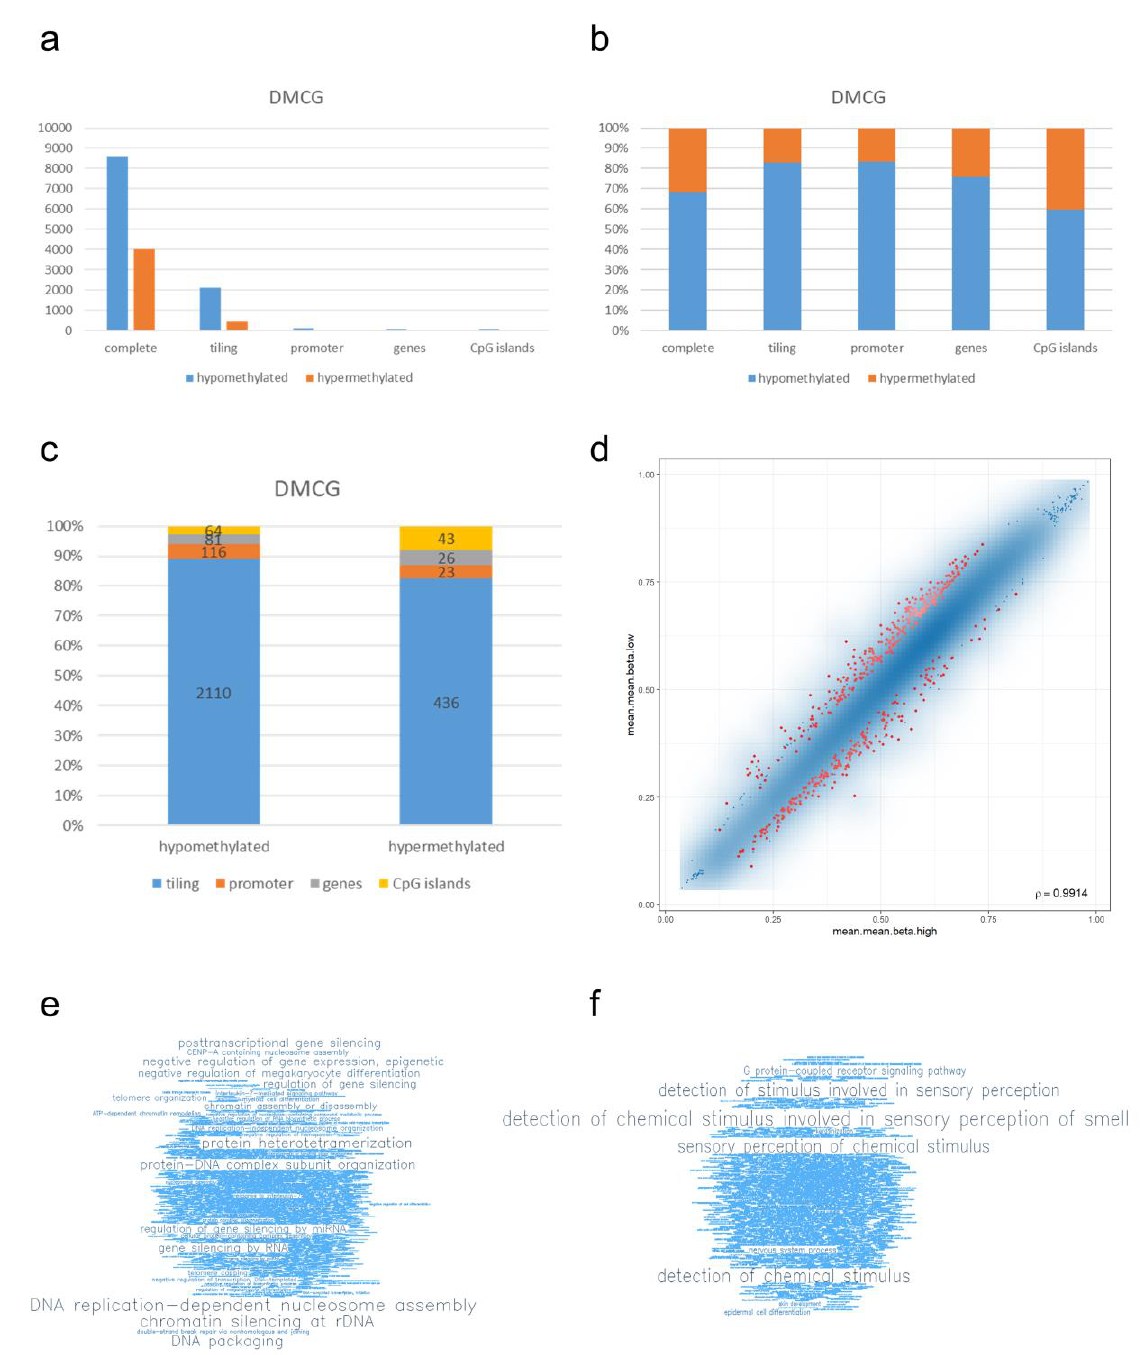
Figure 3. Differential methylation analysis. Differential methylation analysis revealed 12,597 DMCGs ( a ). Thereby, PD-L1 high-expressing glioblastomas showed global hypomethylation compared with PD-L1 low-expressing glioblastomas ( b ). Allocating DMCGs on genomic positions revealed more than 80% being located in tiling regions while less than 10% are in promoter, gene and CpG island regions ( c ). For GO enrichment analysis, top 500 ranked regions (indicated in red) were processed ( d ). Word clouds show GO term enrichments of “DNA replication-dependent nucleosome assembly”, “chromatin silencing at rDNA”, and “DNA packaging” in hypermethylated gene regions, and ( e ) “G protein-coupled receptor signaling pathway” in hypomethylated gene regions ( f